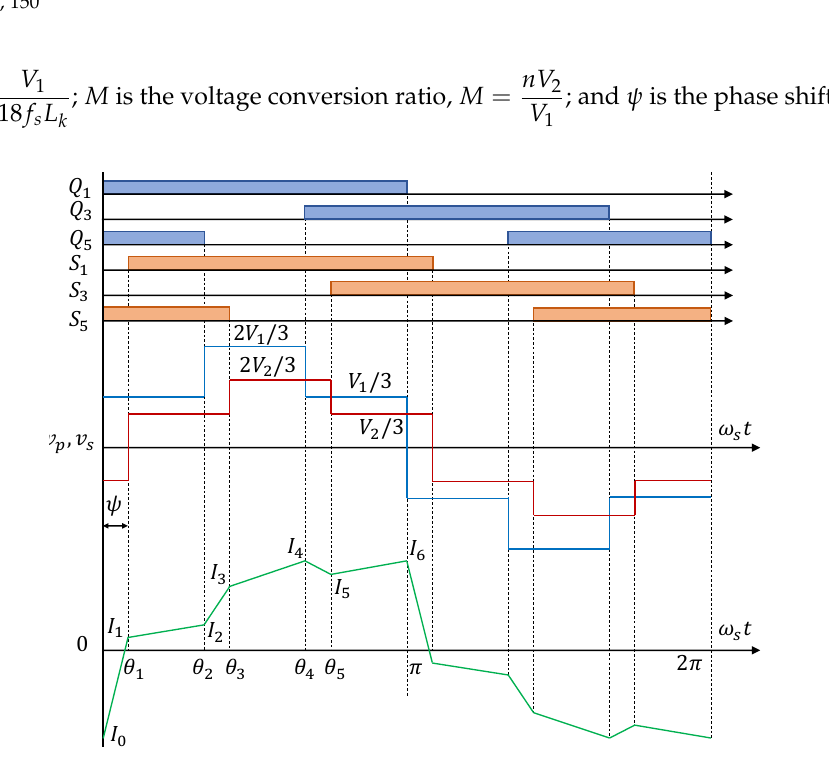
Figure 3. Theoretical voltage and current